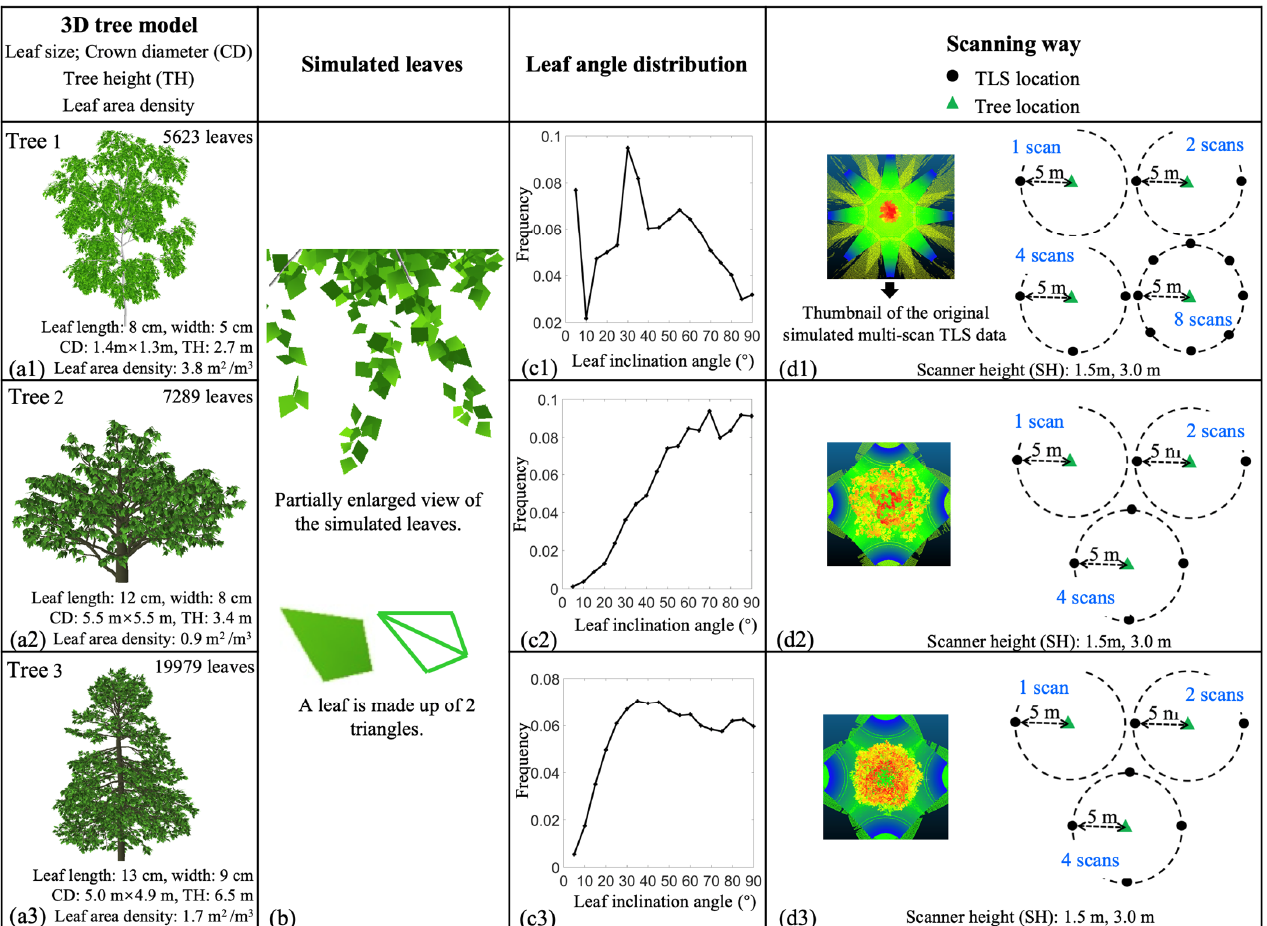
Figure 1. Overview of the simulated data. The three-dimensional (3D) tree models generated in OnyxTREE with different structures, and the details of the number of leaves, leaf size, crown diameter (CD), tree height (TH), and leaf area density are shown in ( a1 – a3 ). Examples of the leaves and leaf structure of the three tree models are illustrated in ( b ). Each leaf is made up of two triangles with a common edge. ( c1 – c3 ) are the true leaf angle distribution (LAD) curves, and ( d1 – d3 ) illustrate the TLS scanning strategy in the Discrete Anisotropic Radiative Transfer (DART) model for the three tree